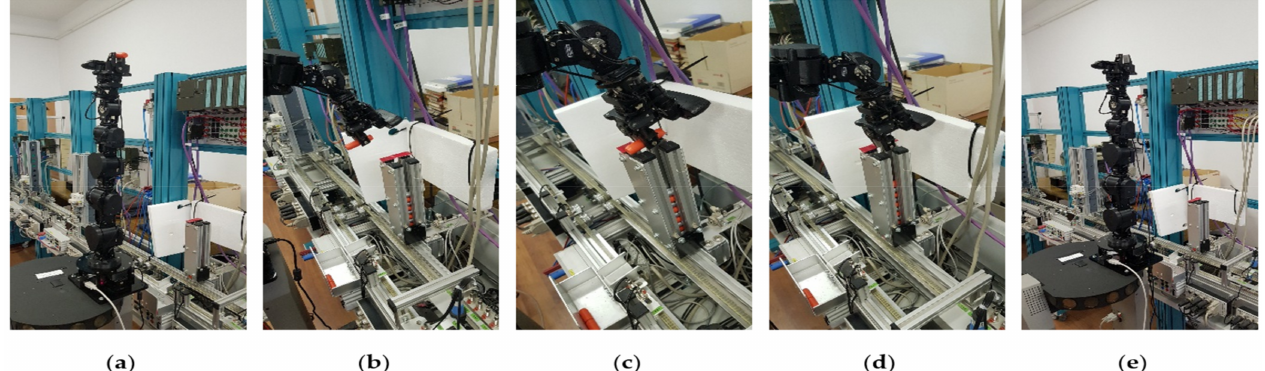
Figure 21. Real-time control of the RM Cyton located at the cylinders warehouse which has the resulting actions: ( a ) parking position with the object in the gripper, ( b ) scanning position, ( c ) moving above the warehouse, ( d ) placing the piece in the depot, ( e ) returning to home position.